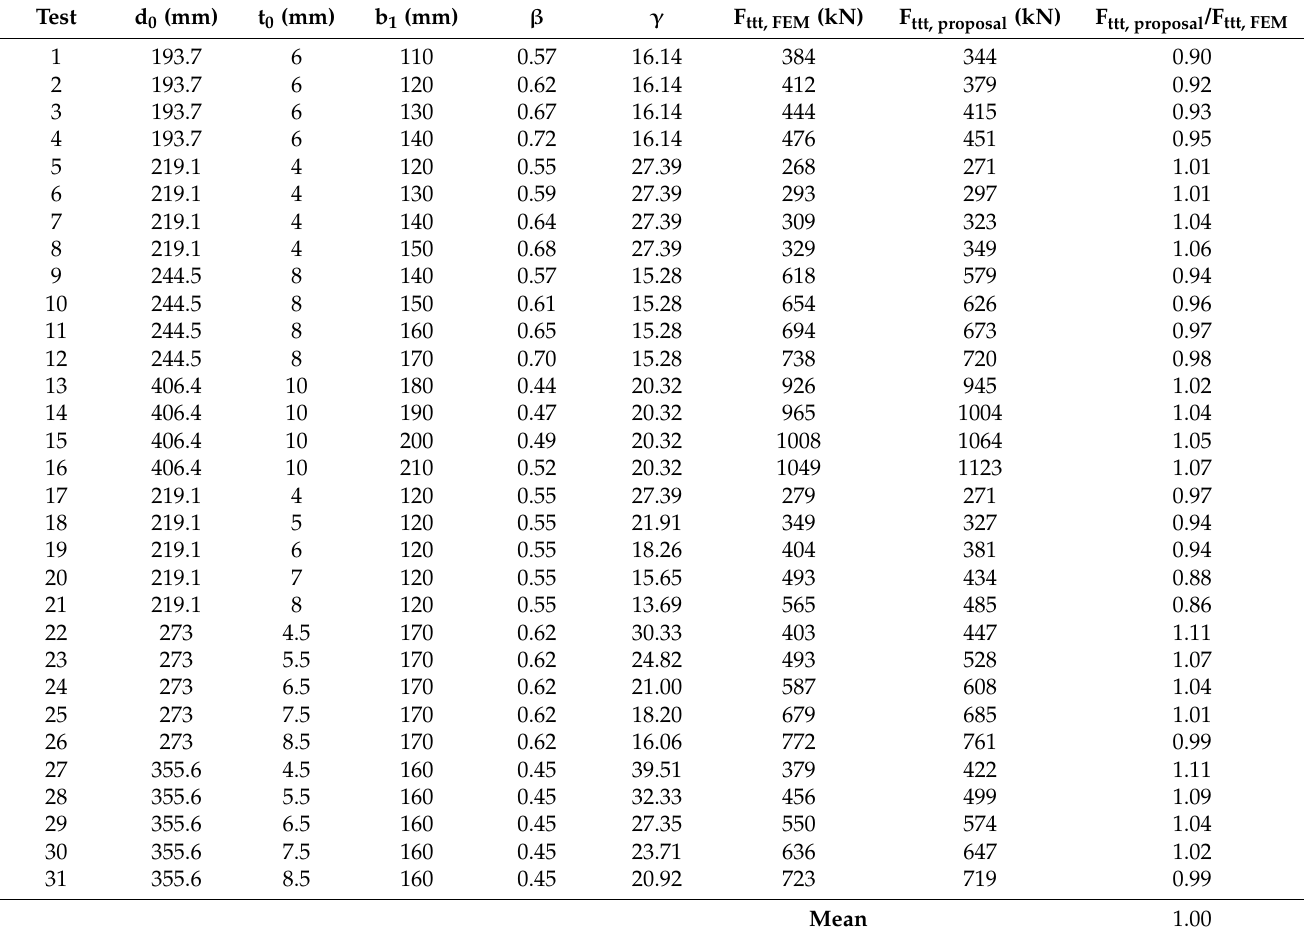
Table 4. Validation of the proposed formulation related to the strength in